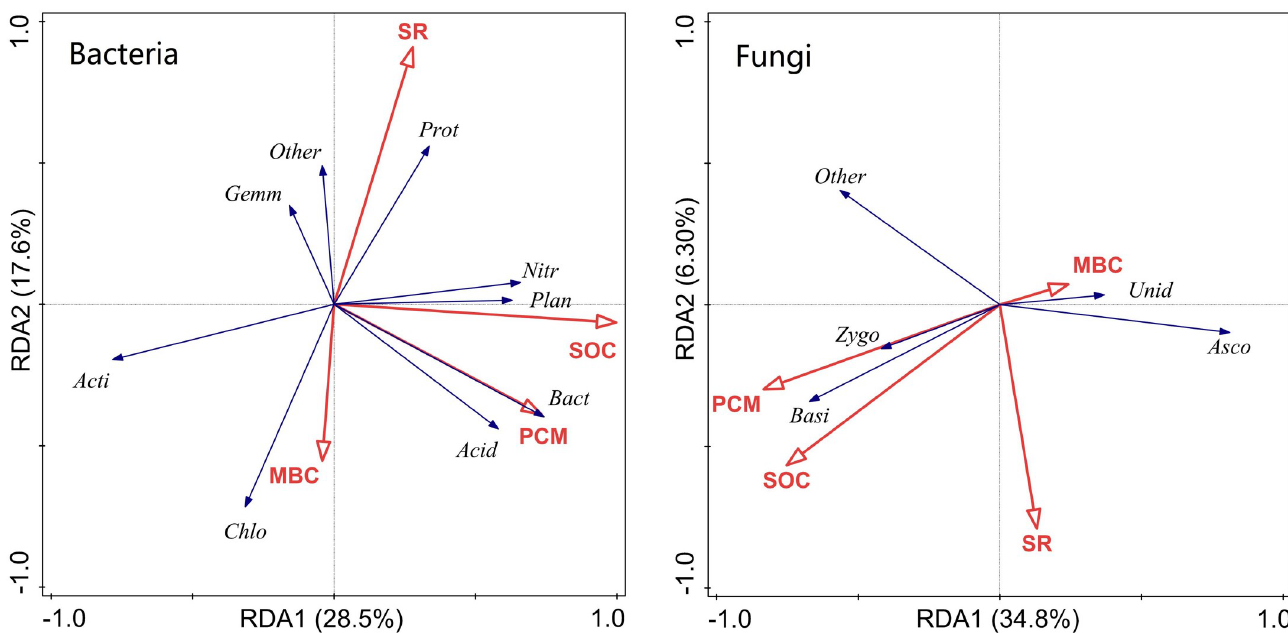
Fig 7. Plots of the eigenvectors from Redundancy Analysis (RDA) in the plane of the first two axes to show the relations among the microbial populations (black arrows) and soil C fractions and respiration (SR) (red arrows). Proteobacteria (Prot), Actinobacteria (Acti), Chloroflexi (Chlo), Acidobacteria (Acid), Gemmatimonadetes (Gemm), Nitrospirae (Nitr), Planctomycetes (Plan), Bacteroidetes (Bact), Ascomycota (Asco), Zygomycota (Zygo), Basidiomycota (Basi) and unidentified (unid).